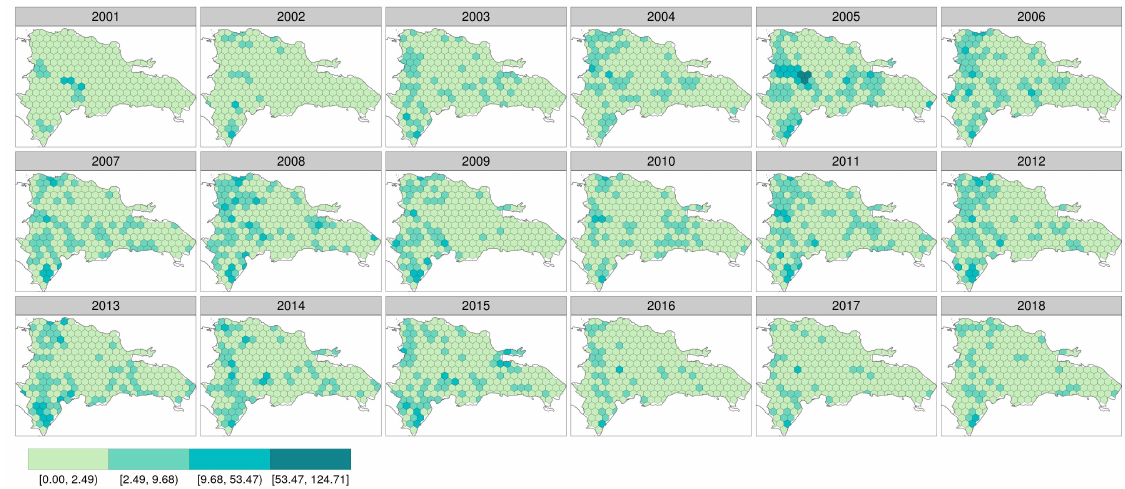
Figure S10 – Yearly number of MODIS fire points per 100 km 2 within patches of forest loss and surroundings for the period